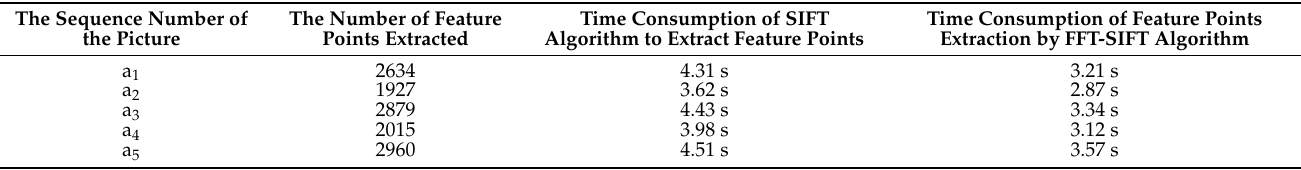
Table 1. Comparison of the feature points extraction by the different algorithms. The Sequence Number of The Number of Feature Time Consumption of SIFT the Picture Points Extracted Algorithm to Extract Feature Points